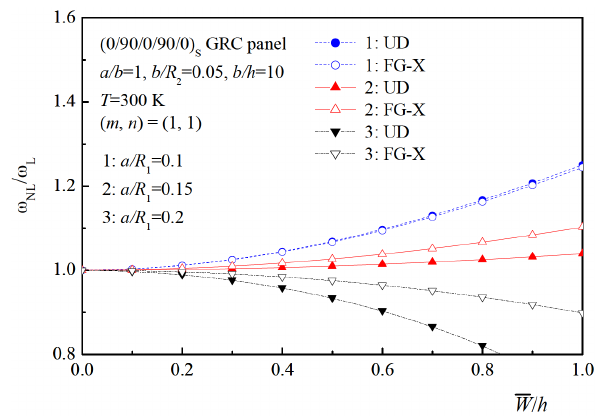
Figure 5: Influence of panel curvature ratio a/R 1 on the frequency- amplitude curves of doubly curved (0/90/0/90/0) S GRC laminated panels